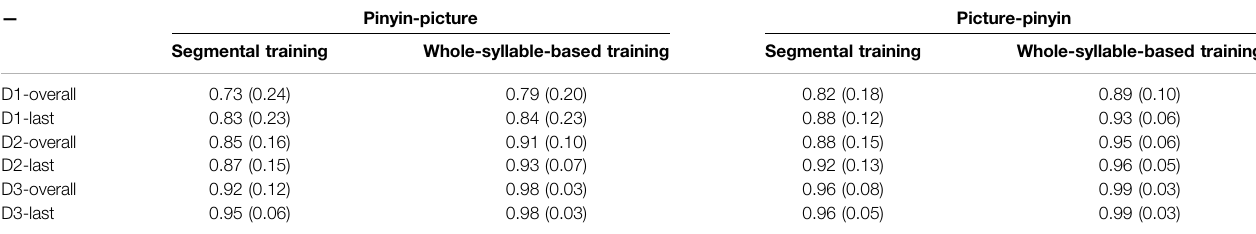
TABLE 4 | The accuracy rate of vocabulary testing and review in both segmental and whole-syllable-based training groups. — Pinyin-picture Picture-pinyin Segmental